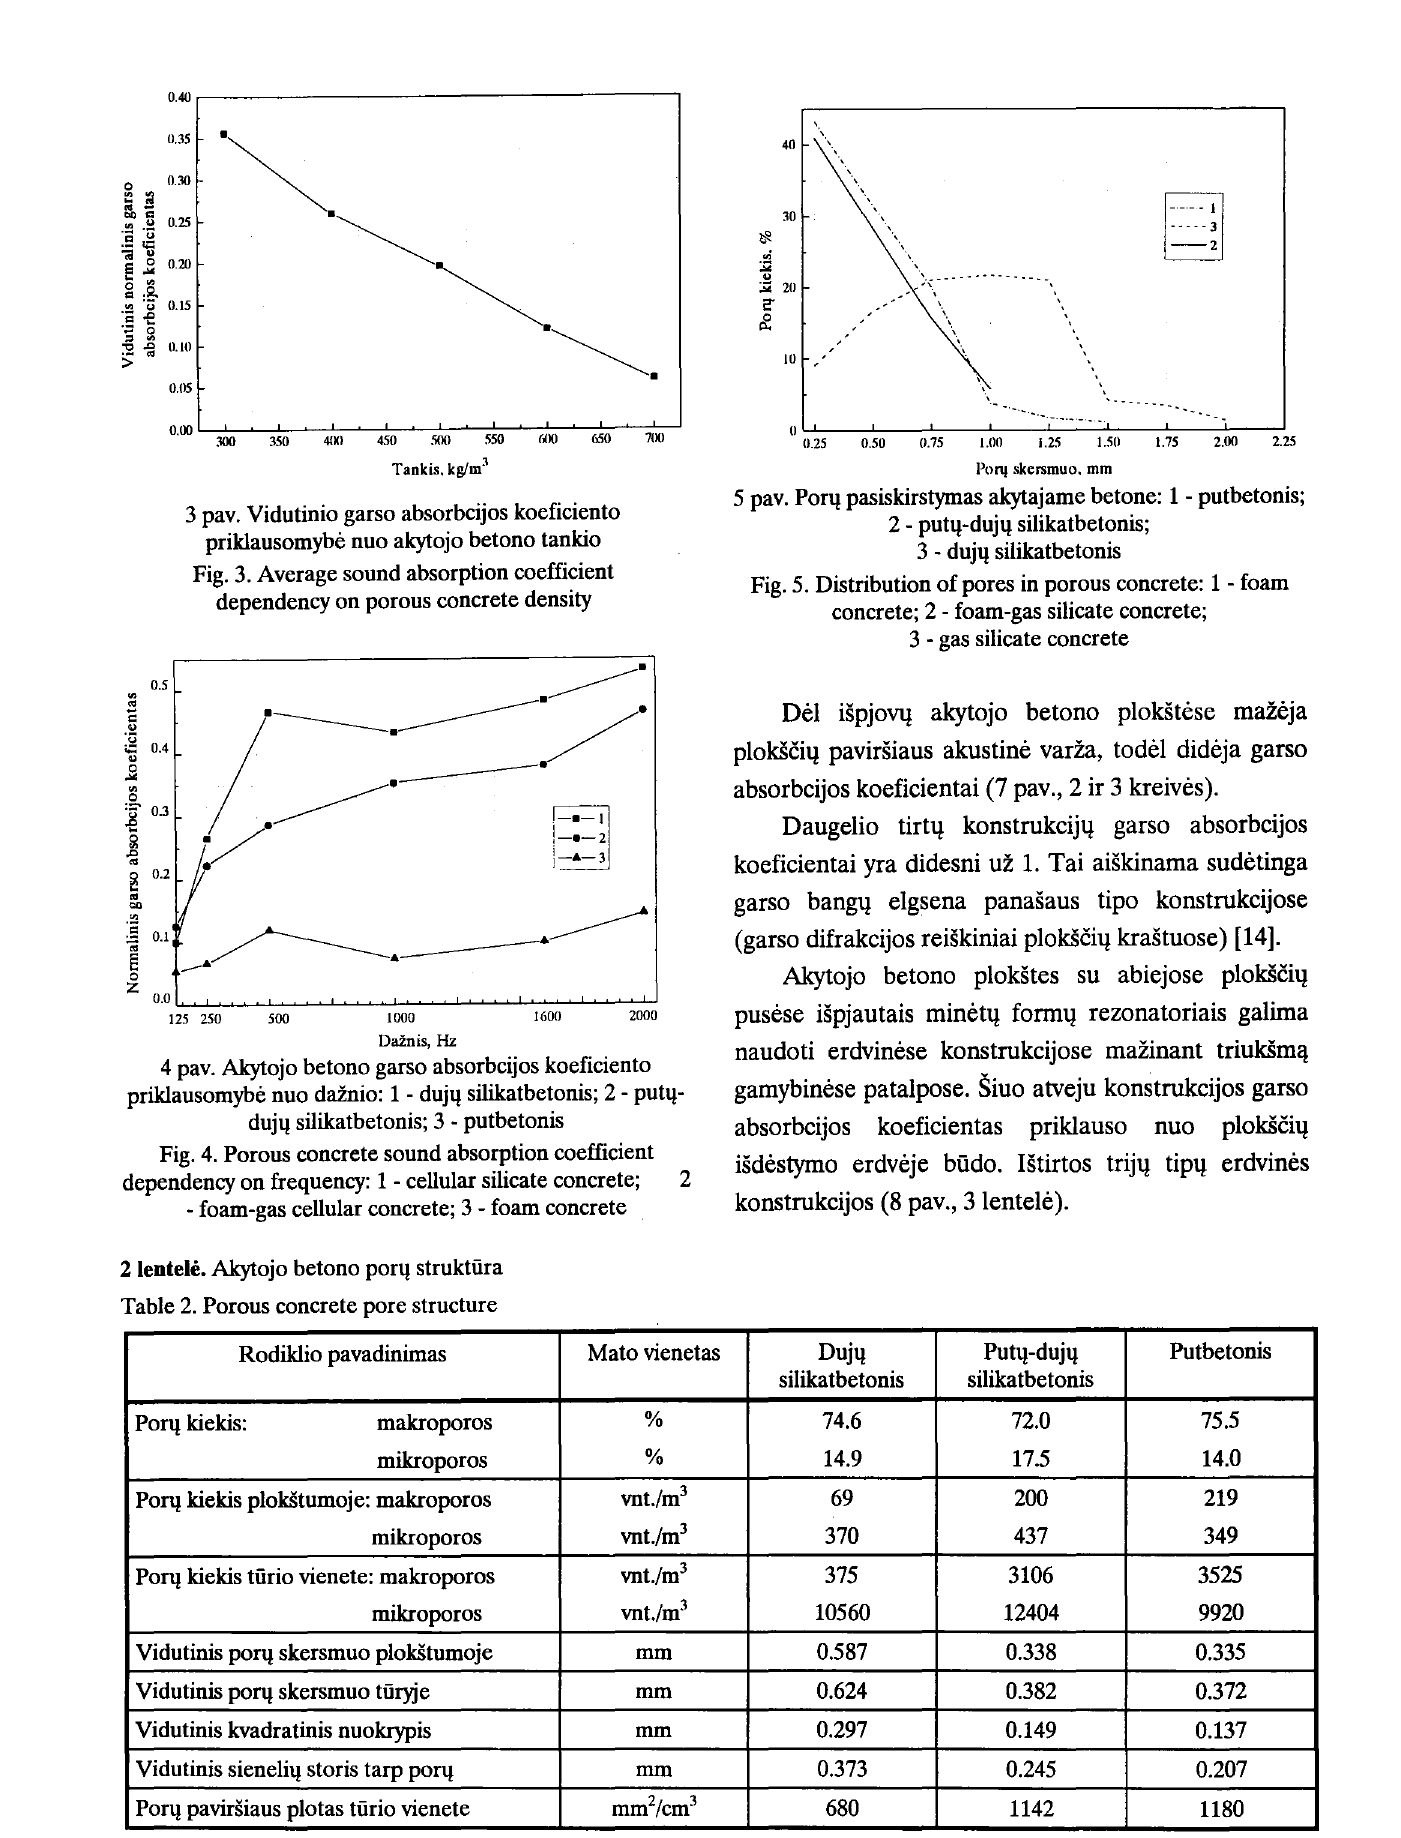
mikroporos Vidutinis porq skersmuo plokStumoje Vidutinis porq skersmuo turyje Vidutinis kvadratinis nuokrypis Vidutinis sieneliq storis tarp porq